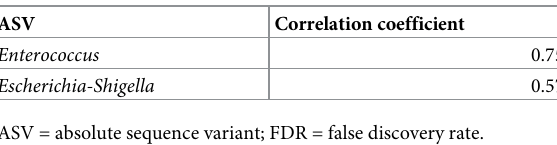
Table 3. ASVs with relative abundance correlated with fructosamine.